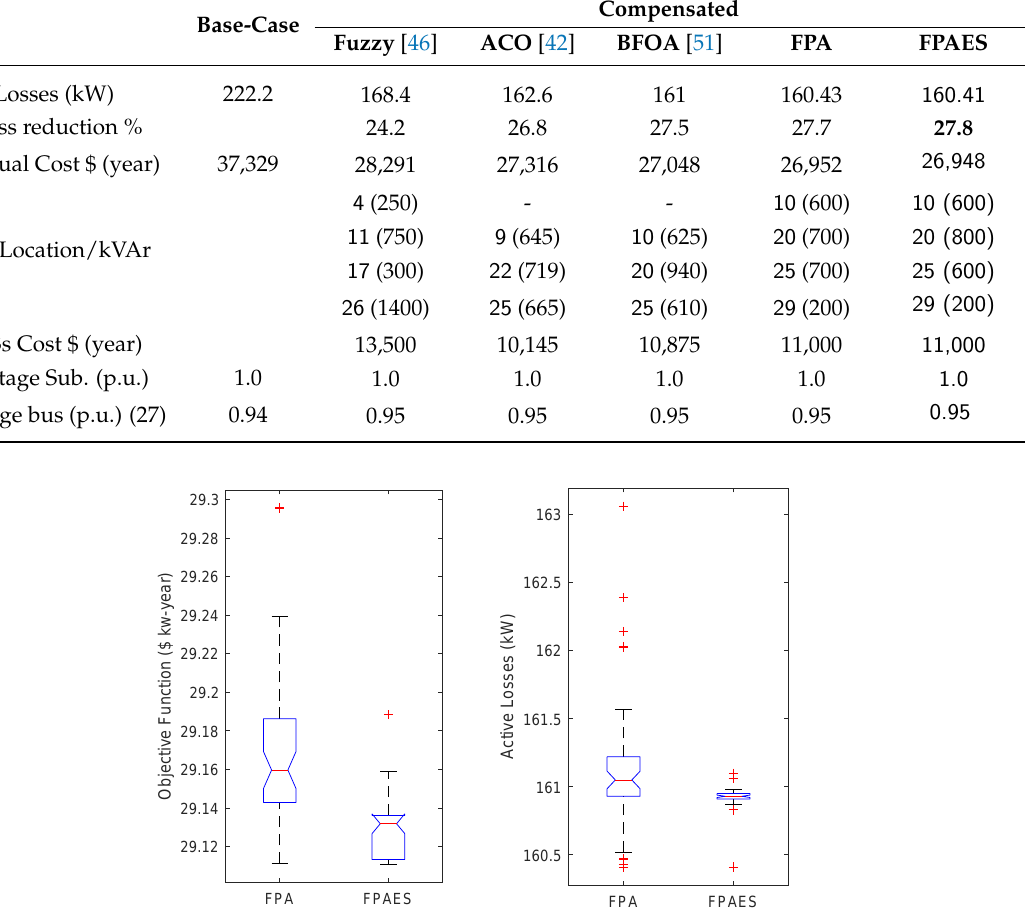
Table 5. Simulation results of 34-bus system.